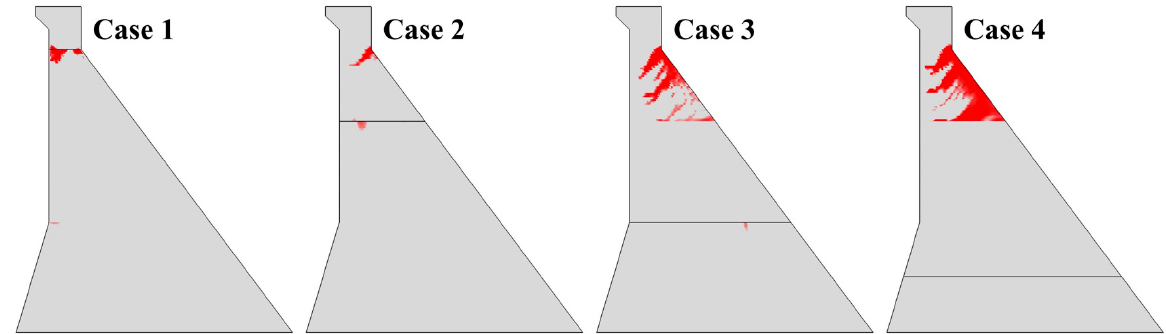
Figure 17. Damage characteristics of the dam with a weak layer for the four cases.